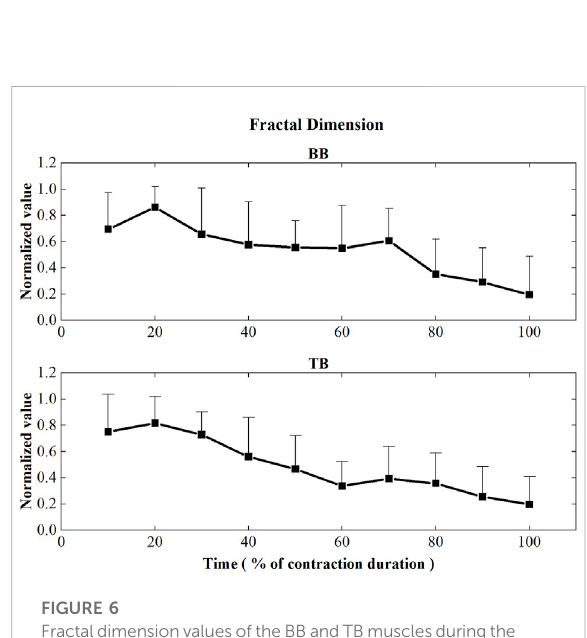
FIGURE 6 FractaldimensionvaluesoftheBBandTBmusclesduringthe sustained fatiguing contraction. For each subject, data have been normalized relative to the maximum and minimum values of the contraction, and thetime base has been normalized to